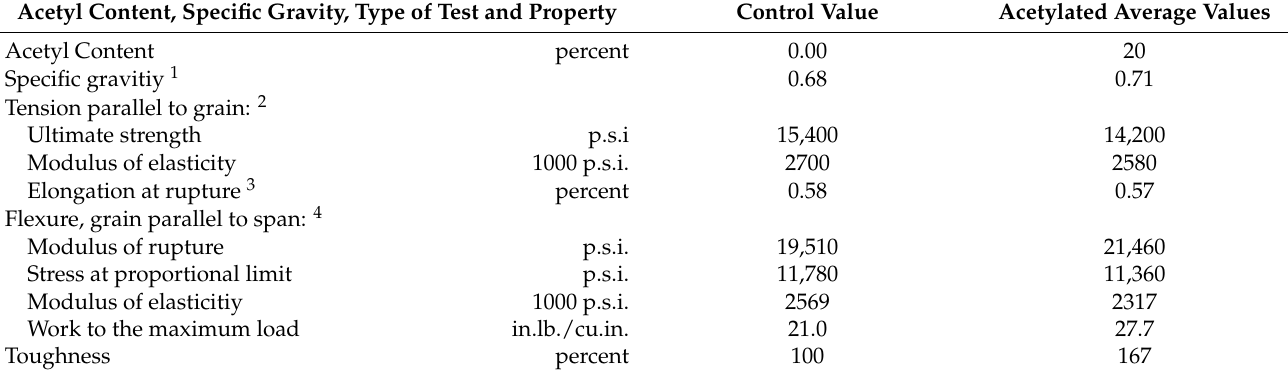
Table 6. Mechanical properties of control and acetylated yellow birch rotary-cut 1/8-inch veneers [7]. Acetyl Content, Specific Gravity, Type of Test and